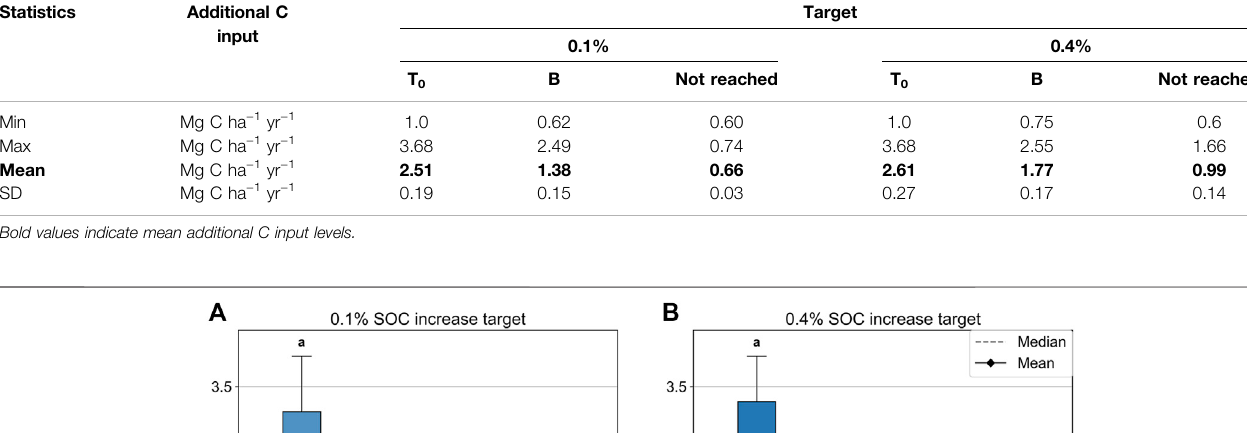
TABLE 5| Amount ofadditionalcarbon (C)input(Mg C ha − 1 yr − 1 )(relative tothe Cinputinthecontrol treatment) thatincreased soilorganic carbon (SOC) stocksby0.1 and 0.4% yr − 1 on average for 30 years, according to T 0 and B. Additional C input refers to exogenous organic matter (EOM) inputs plus C input from increased crop growth relative to the control treatment. Additional C